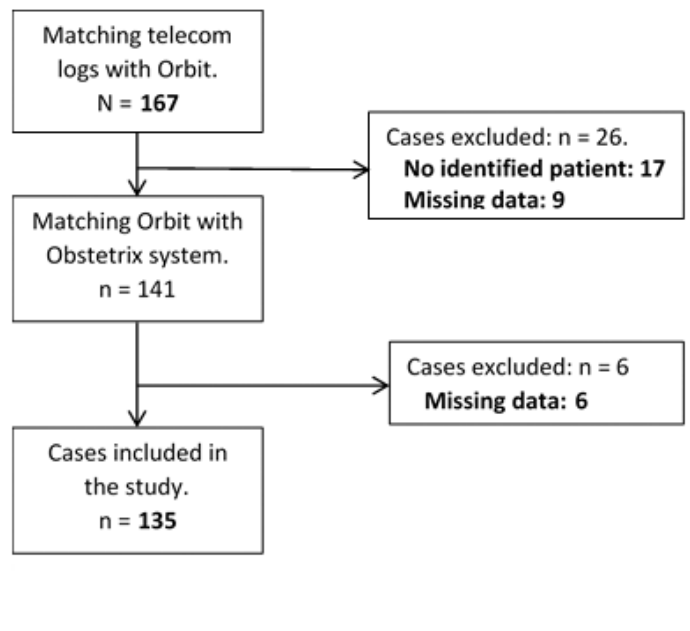
Figure 1. Patient inclusion.